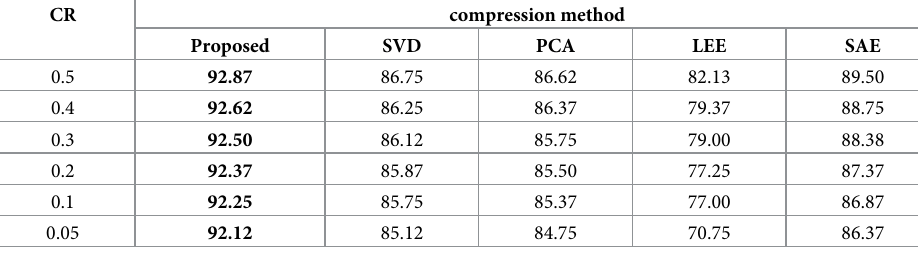
Table 9. Accuracy of different compression methods in TianChi ECG signal database test set at different com- pression ratios.